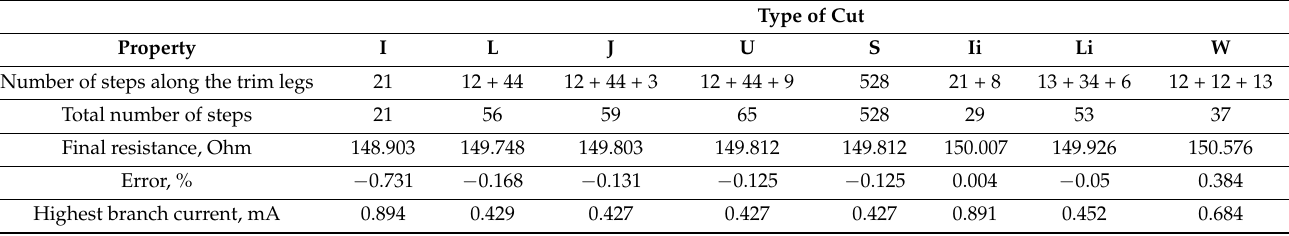
Table 10. ResModel trim simulation results.